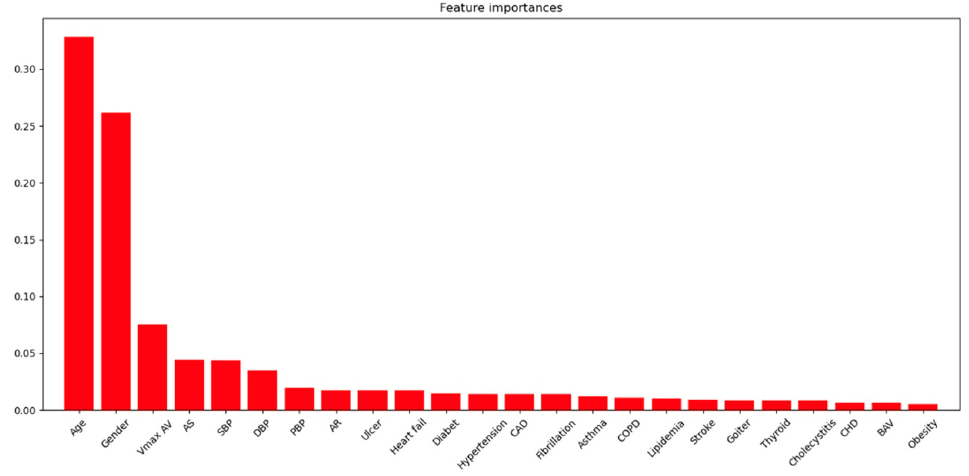
Figure 2. Features importance analysis.